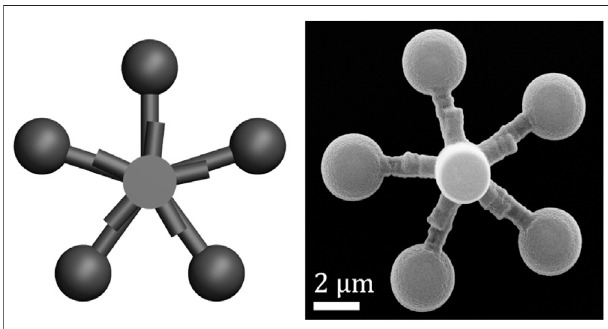
FIGURE1| Themicropropellerusedintheexperiment. (Left) Schematic of the design, rendered using POV-Ray, (right) SEM image of the